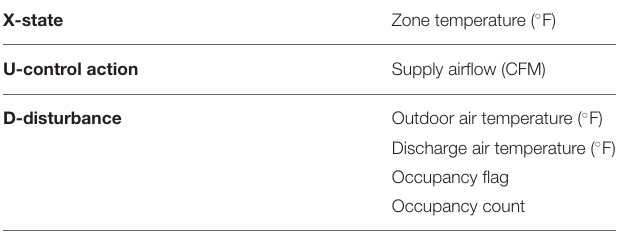
TABLE 4 | The state, action, and disturbance terms defined for controlling a real-world conference room.